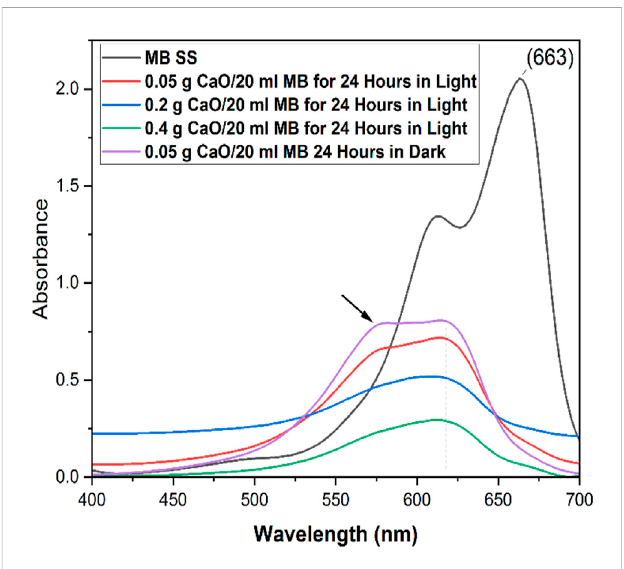
FIGURE 13 UV – Vis spectra of MB solution with different doses of CaO for 24 h in natural light and in